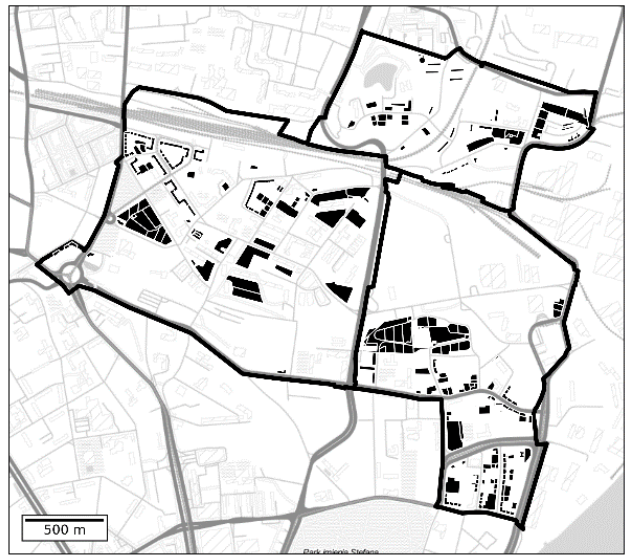
Figure 2. Designated location of the attractiveness zones.